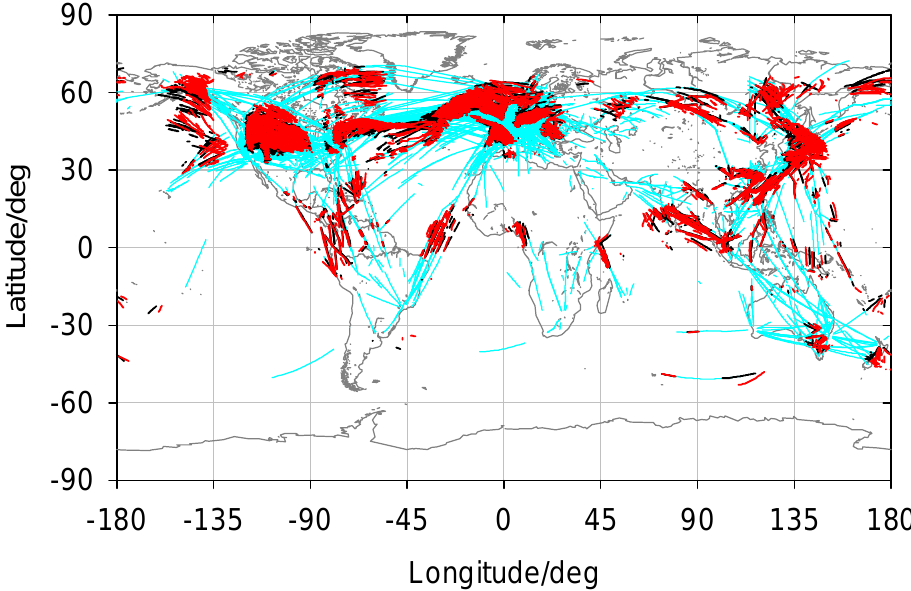
Fig. 6. Contrail forming flight paths (cyan) for global traffic between 03:00–06:00 UTC 6 June 2006. Contrails existing at 06:00 UTC that day are identified by red lines. Those parts of the tracks where these contrails originated are shown in